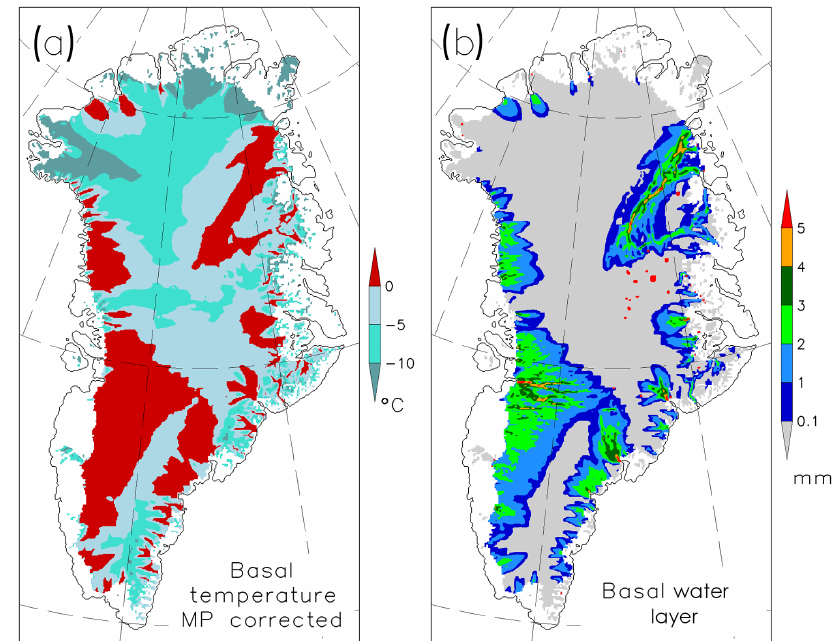
Figure 9. Simulated 2-D basal fields. (a) Basal temperature relative to pressure melting (in ◦ C), (b) thickness of basal water layer (in mm). Table 2. Simulated GrIS contribution to sea level rise for the years 2100 and 2300 in cm. Rows specify the different GCMs used by MAR. Columns list the RCP scenarios used by the MAR GCMs and whether we excluded or included the elevation SMB feedback ∂M/∂z in our simulation. MAR GCM Year 2100 [cm] Year 2300 [cm] RCP 4.5 RCP 8.5 RCP